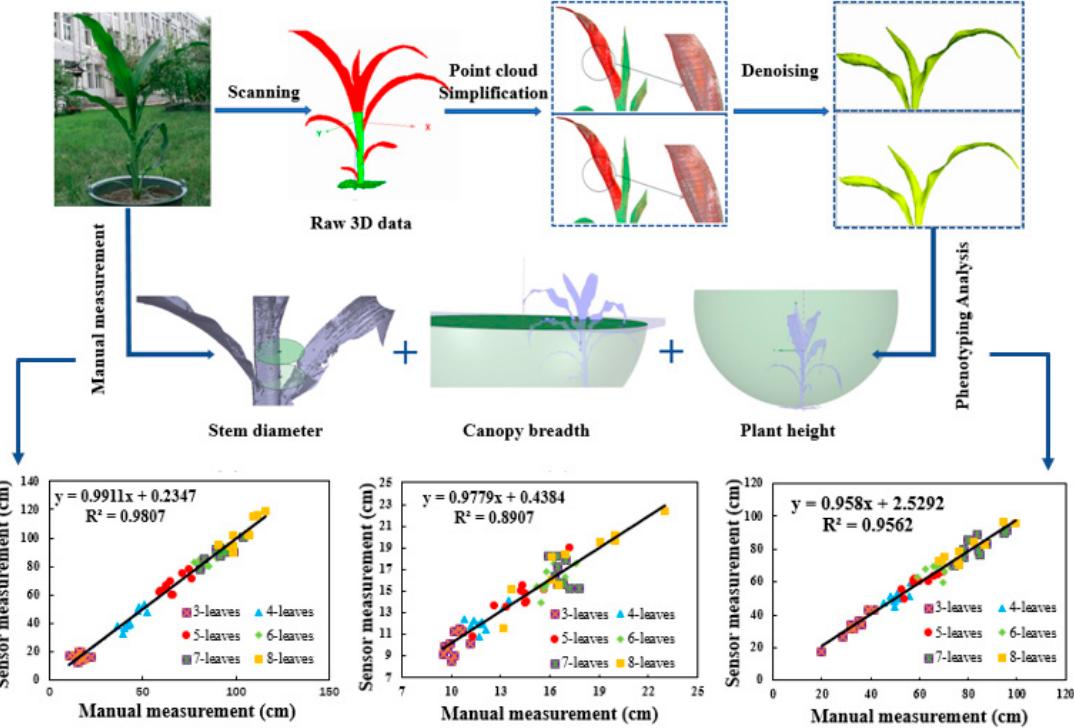
Figure 2. Flow chart for calculating the phenotypic traits of maize plants.